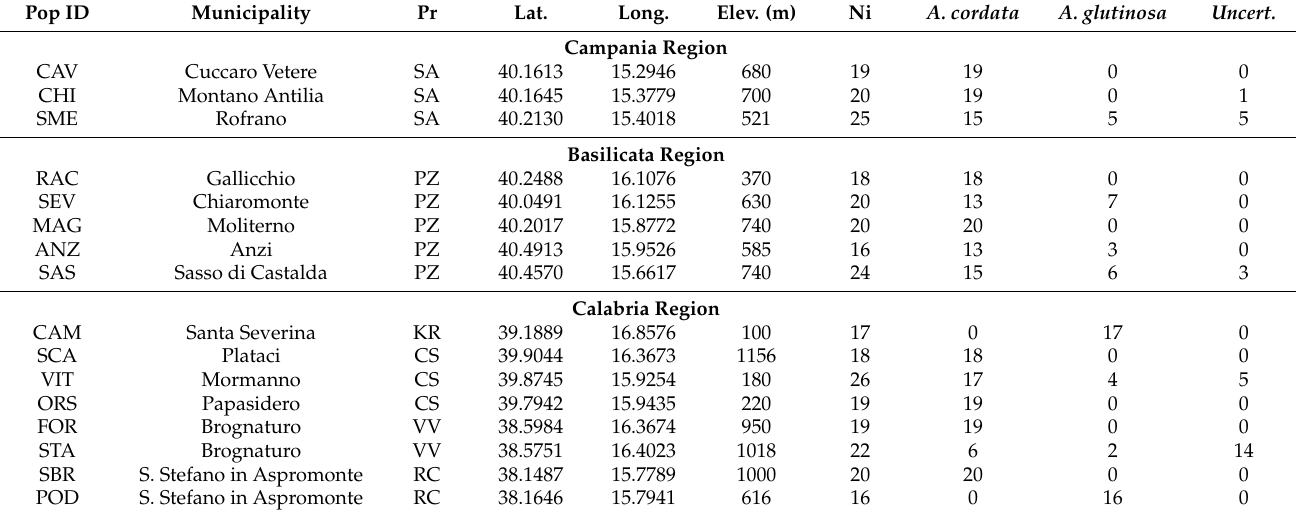
Figure 1. Distribution range (Euforgen. Available online http://www.euforgen.org/species/, accessed on 20 May 2021) of A. cordata and A. glutinosa and sampling sites of the 16 populations analyzed in this study. Table 1. Geographic and sampling information of 16 A. cordata and A. glutinosa populations: population code (Pop ID), sampling site (Municipality), province (Pr), geographic coordinates in decimal degrees, latitude (Lat.) and longitude (Long.), elevation above sea level (Elev.), number of individuals sampled (Ni). The last three columns present the number of individuals with morphological assignment to each species or to uncertain